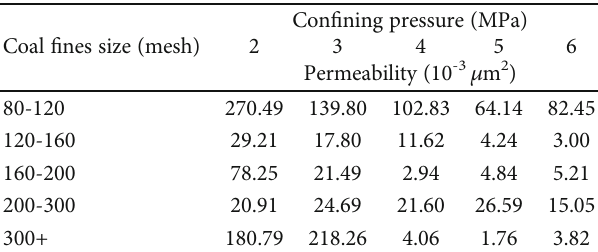
Figure 4: E ff ect of fl ow velocity and con fi ning pressure on permeability. Table 4: Permeability of coal fi nes intrusion at di ff erent con fi ning pressure.